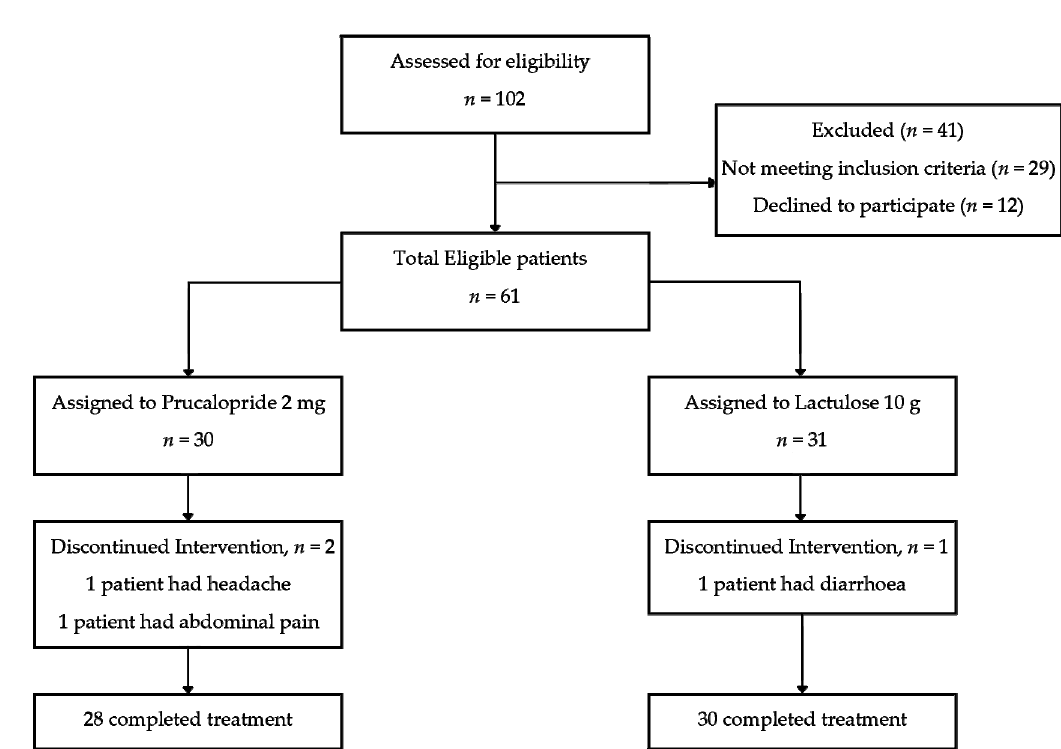
Figure 1. Disposition of patients in the open label, head to head comparison study between Prucalopride and Lactulose for Clozapine induced constipation in patients with treatment resistant